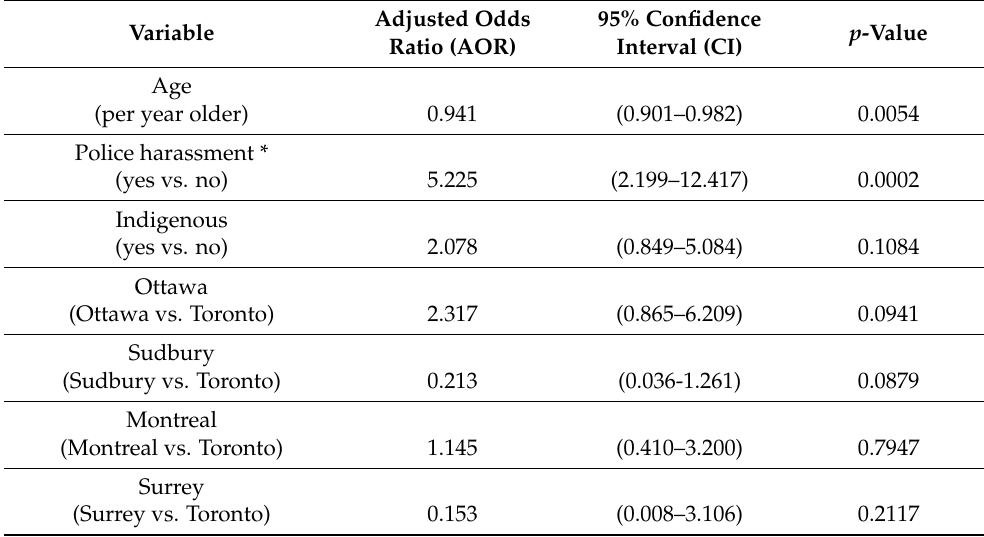
Table 2. Adjusted odds ratios for variables associated with sex workers being unable to call 911 in a safety emergency due to fear of police detection of them, their managers or their co-workers ( n =